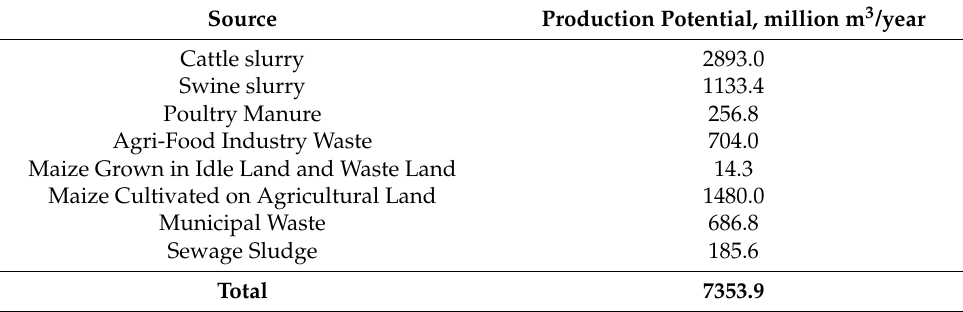
Table 1. Structure of potential sources of biomethane in Poland